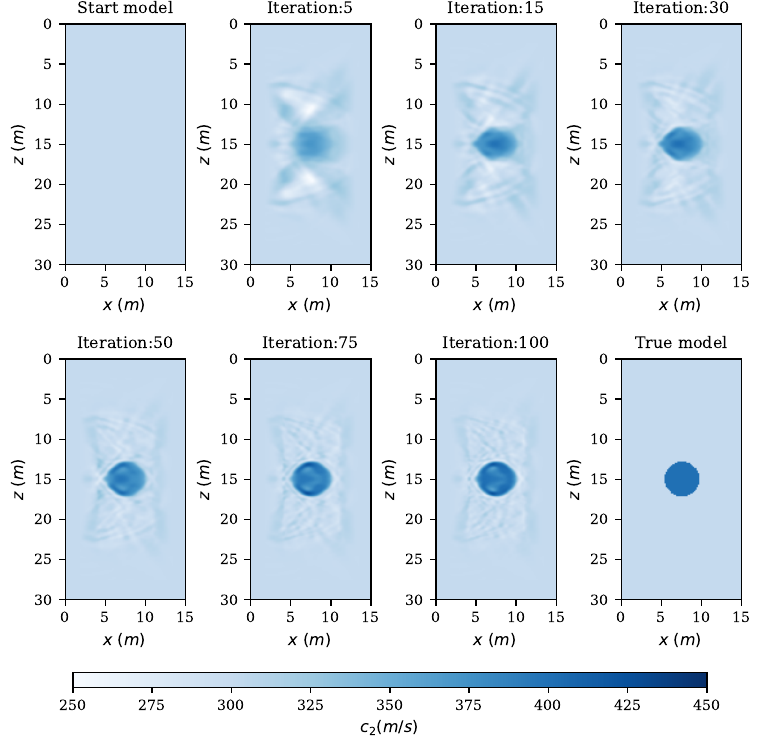
Figure 16. Shear wave velocity inversion at different iteration steps in seismic FWI of a spherical inclusion in